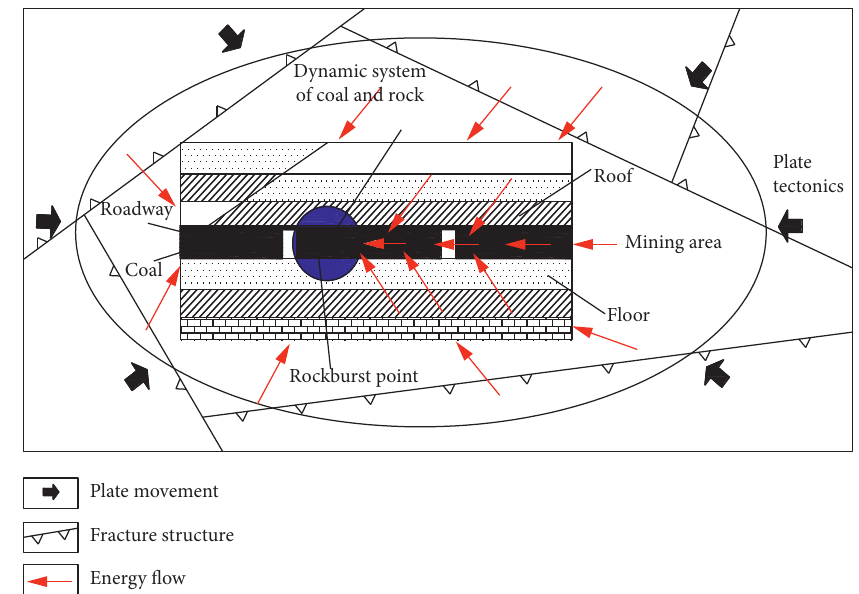
Figure 2: Energy sources of the coal-rock dynamic system.